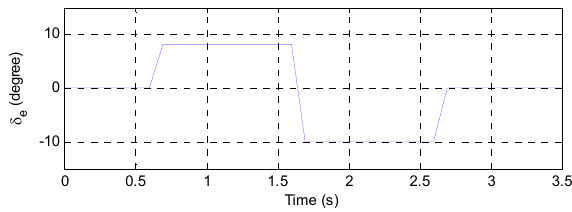
Figure 3. Elevator doublet with time step of 1 s as input.